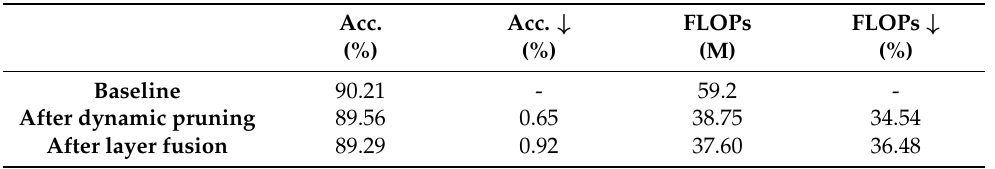
Table 3. Compression results of DenseNet-121 on ImageNet50. “After layer fusion” indicates the result of layer fusion after dynamic